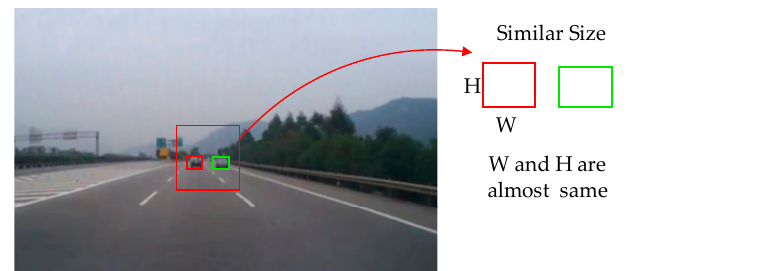
Figure 5. Preceding vehicle sizes when experimental vehicle exceeded 90 km/h. Small vehicle sizes are similar, and the width (W) and height (H) of each vehicle are close.